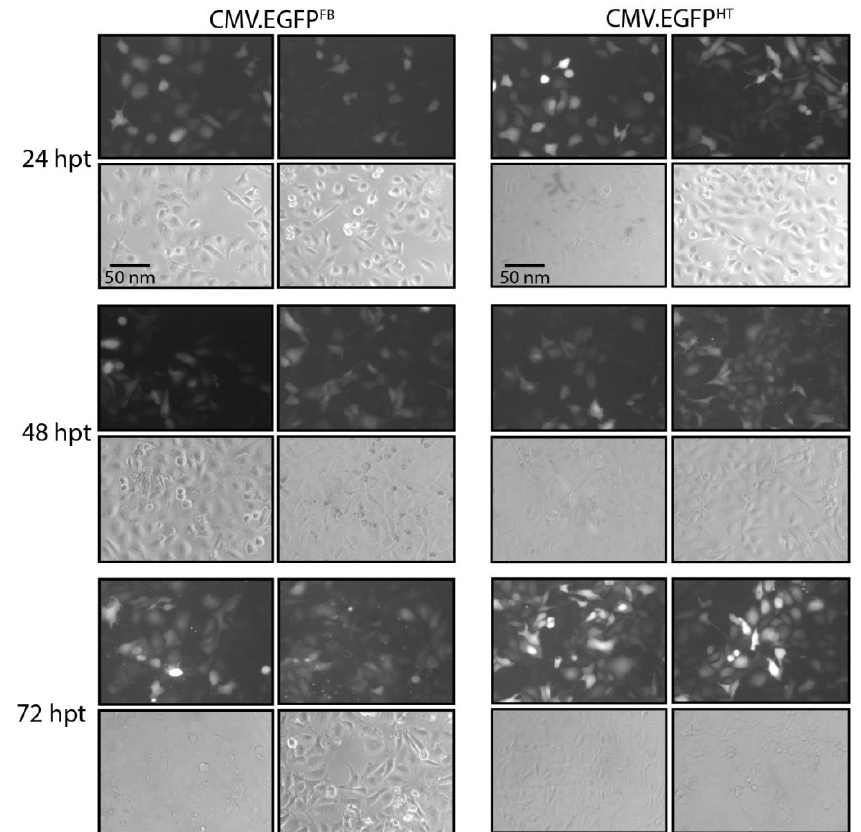
Figure 2. Representative images of bright (lower panels) and fluorescent (upper panels) fields of HK-2 cells transduced with CMV.EGFP FB (FB) or CMV.EGFP HT (HT) BacMam viruses at ‘multiplicity of infection’ of 150. Images were taken 24, 48 and 72 hpt using a Zeiss Axiovert 135 inverted epifluorescence microscope (10×). Duplicate images are shown for each virus and time point. Scale-bar, 50 nm.